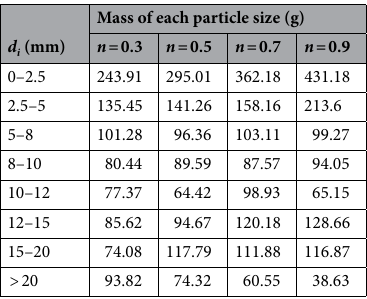
Table 5. Distribution in each particle size interval of the remaining rock skeleton samples in the cylinder.